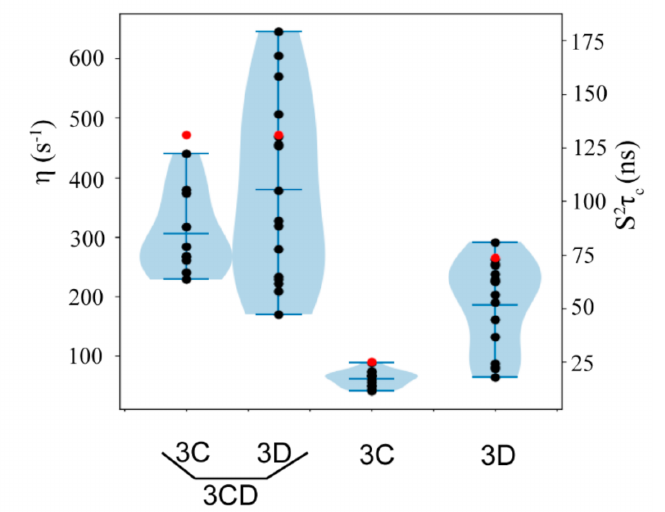
Figure 9. Distribution of intramethyl 1 H- 1 H dipolar cross-correlated relaxation rates ( η ) and the equivalent S 2 τ c values determined by triple quantum relaxation violated coherence transfer NMR experiments for the 3C and 3D domains independently and in 3CD. Values of τ c calculated from HydroNMR are shown in red. Mean ± standard deviation of η : 3C: 62 ± 14 s − 1 , 3D: 186 ± 75 s − 1 , 3C in 3CD: 306 ± 70 s − 1 , 3D in 3CD: 379 ± 153 s − 1